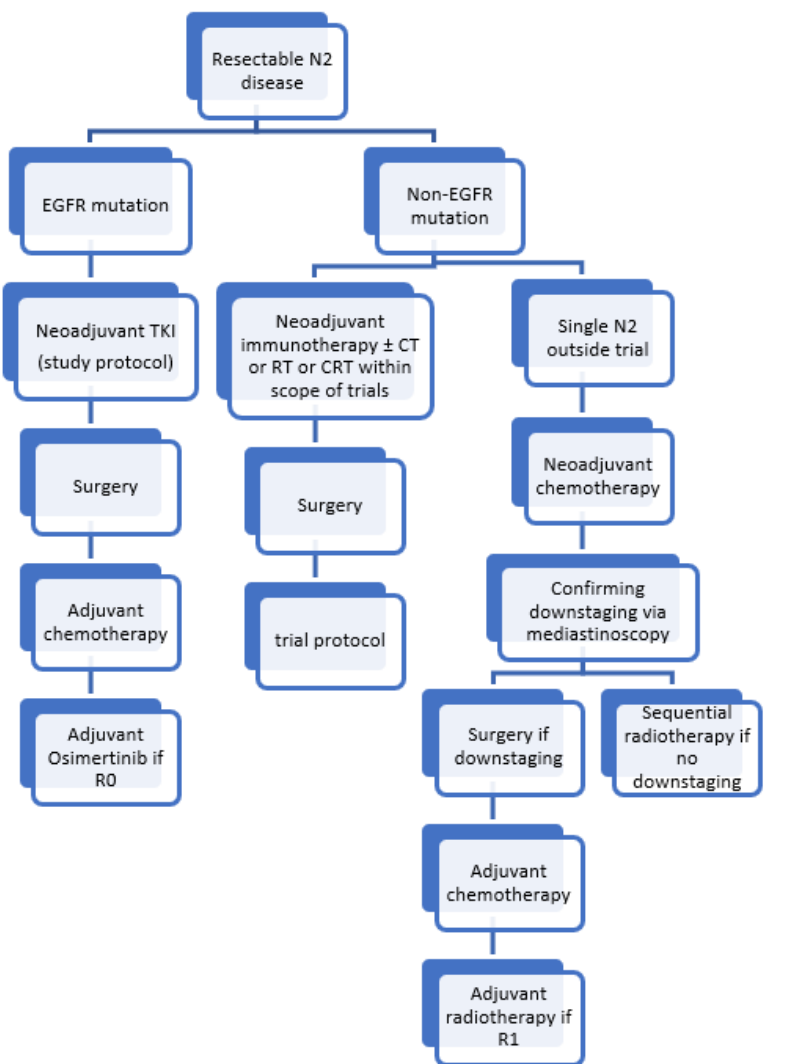
Figure 2. Current treatment algorithm at Antwerp University Hospital for resectable N2 disease. CT, chemotherapy; RT, radiotherapy; CRT, chemoradiotherapy.